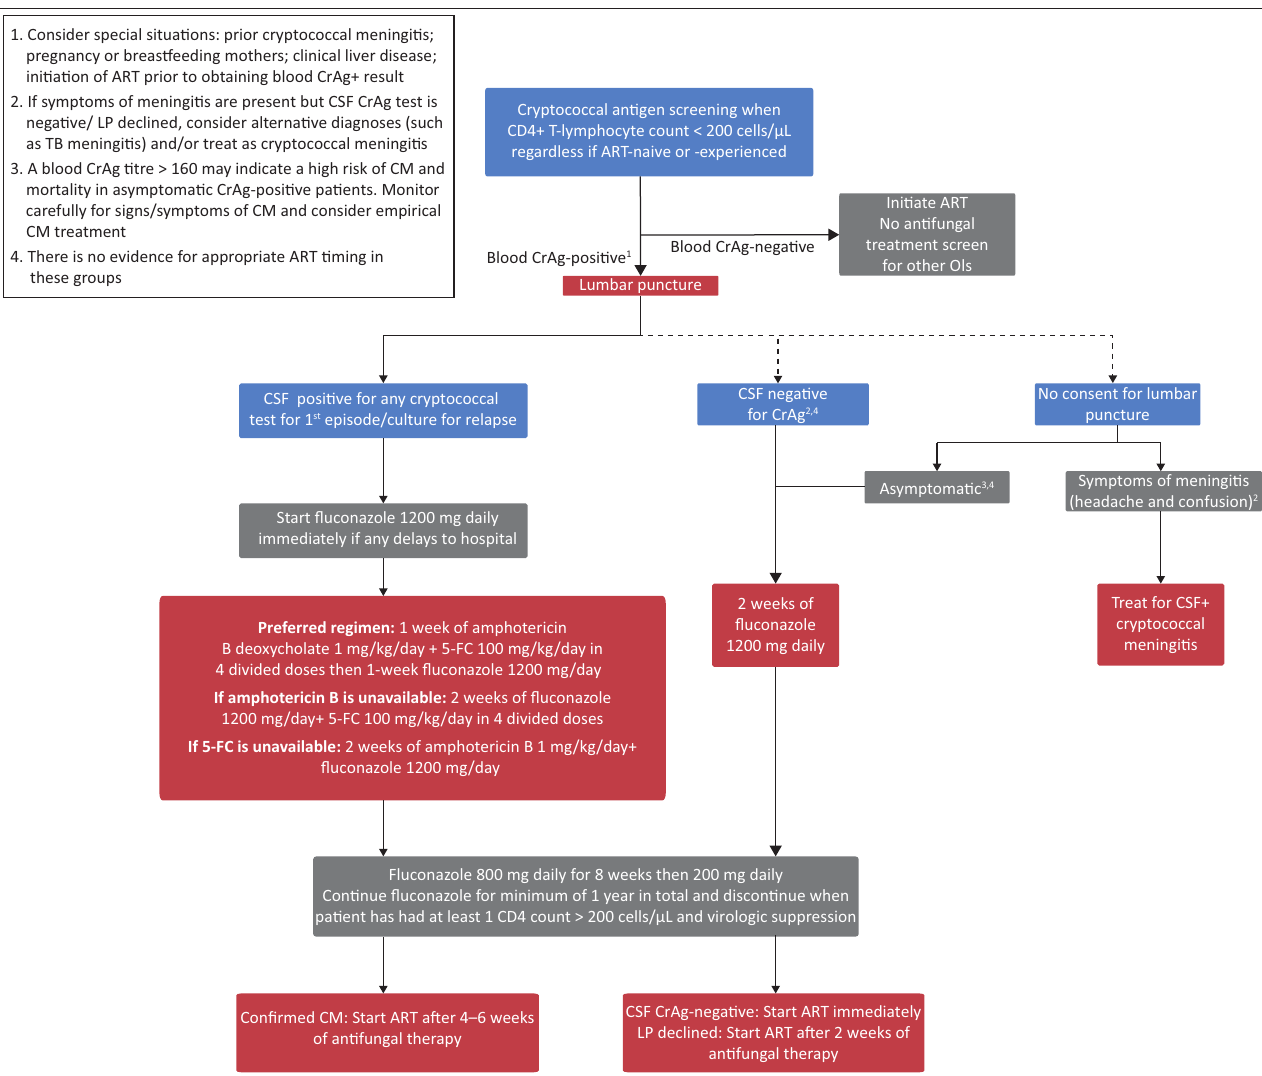
FIG URE 1: Cryptococcal antigen screening and treatment